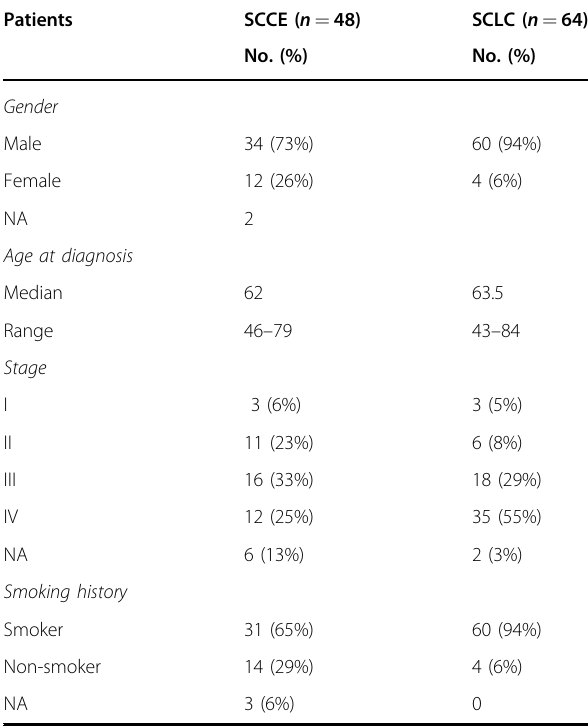
Table 1 Clinical characteristics of patients with SCLC and